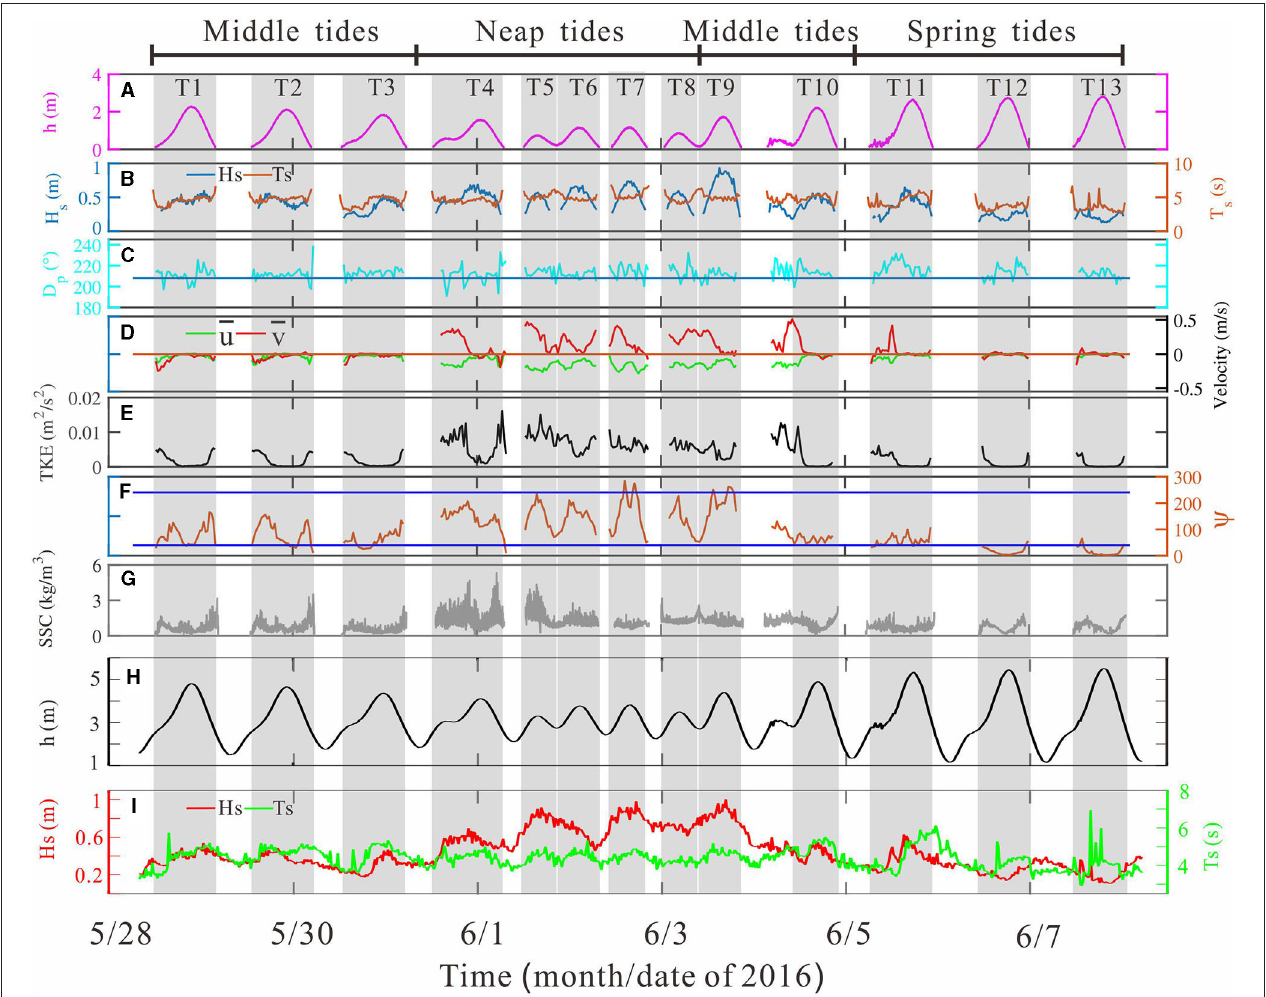
FIGURE 2 | Time series of (A) water depth, h; (B) significant wave height, Hs (blue line), and significant wave period, Ts (red line); (C) peak wave direction, Dp, and horizontal line indicated the normal direction (208 ◦ ); (D) mean cross-shore velocity, u (green line), and alongshore velocity, v (red line); (E) turbulent kinetic energy, TKE; (F) mobility number, ψ (orange line), and two blue lines indicated ψ = 240 and 40, respectively; (G) suspended sediment concentration, SSC at Site A. Time series of (H) water depth, h; (I) significant wave height, Hs (red line) and significant wave period, Ts (green line) at Site B.